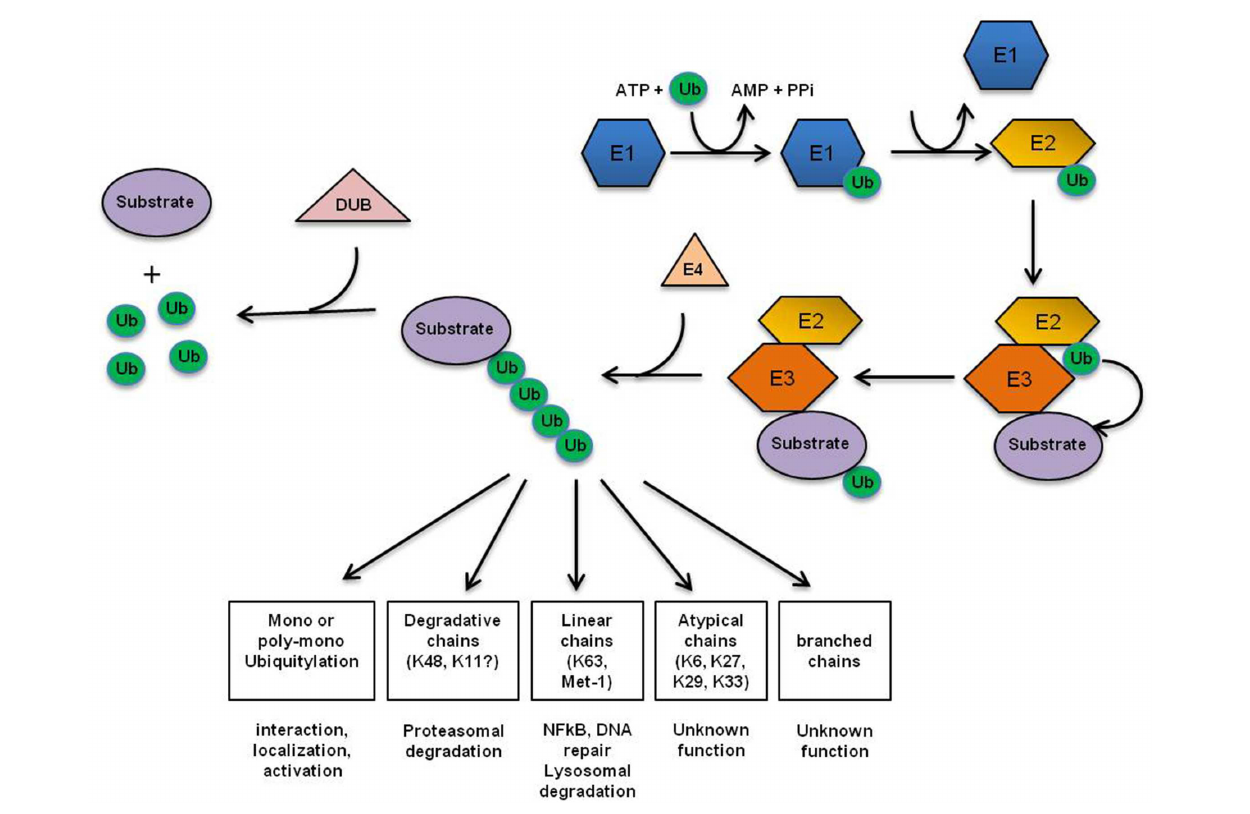
counteract the activity of UB-conjugating enzymes (Nijman et al., 2005). The firstUbiseithertransferredtoa ε -NH2groupofalysineresidue(K)ofthetarget protein to generate an isopeptide bond, or in a linear manner to the N-terminal residue of the substrate (Breitschopf et al., 1998; Pickart, 2001). Subsequent Ub addition can occur through isopeptide linkage on all of ubiquitin’s seven lysine residues as well as its N-terminal primary amino group, thereby generating a diverse range of chain topologies (Met1-linked, K6, K11, K27, K29, K33, K48, K63 or mixed) that can drive a variety of different protein